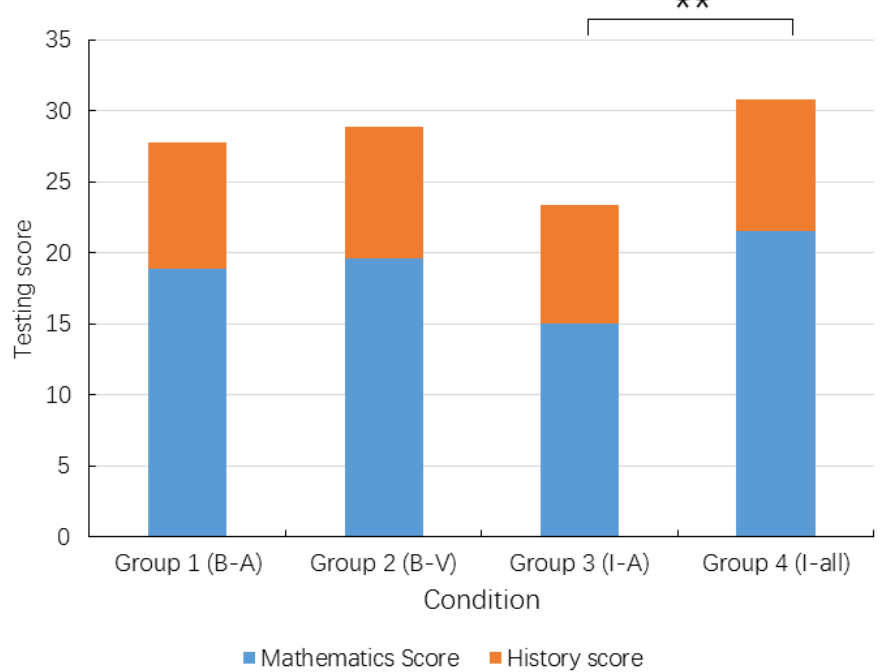
Figure 2. Group differences in test scores. B-A = blocked, auditory condition; B-V = blocked, visual condition; I-A = interleaved, auditory condition; I-all = interleaved auditory and visual condition. ** p < 0.01.